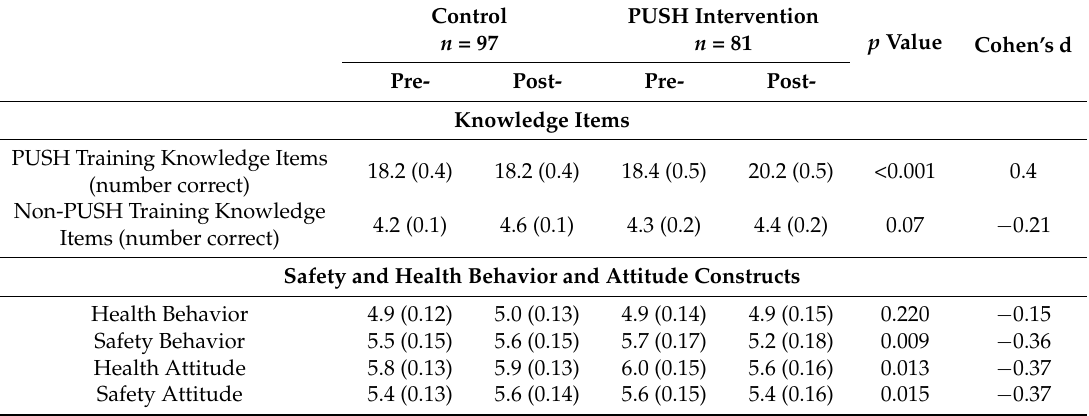
Table 4. Scores for the knowledge plus safety and health behavior and attitude constructs (estimated mean